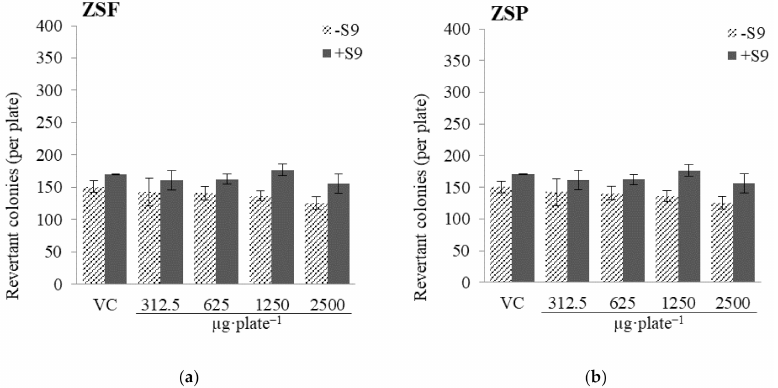
Figure 2. Results of mutagenicity test of Zanthoxylum schinifolium extracts (( a ) ZSF: Z. schinifolium fruit extract, ( b ) ZSP: Z. schinifolium pericarp extract) in Salmonella typhimurium TA100, with or without the S9 mix. In the positive control, the number of revertant colonies are 1025 ± 37 and 753 ± 21, with or without the S9 mix. The S9 mix consists of the rat liver S9 fraction and other co-factors. Data are expressed as the mean ± SD of triplicate experiments. VC, vehicle control